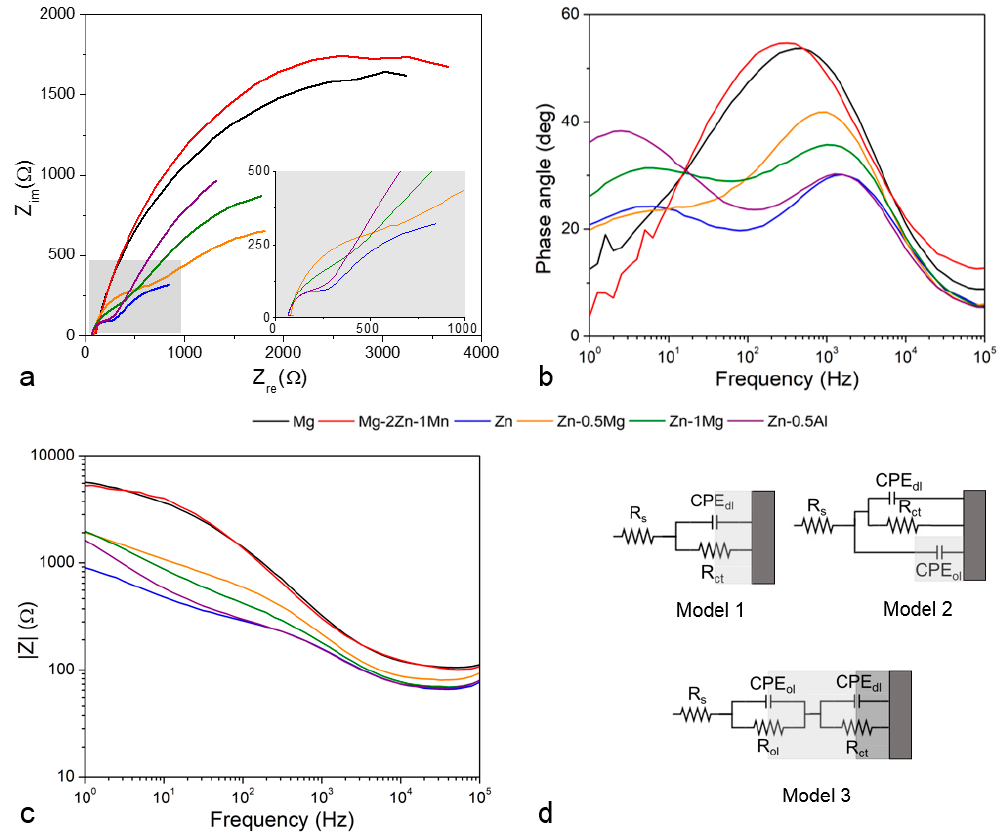
Figure 5. Typical electrochemical impedance spectroscopy (EIS) results: ( a ) Nyquist plots, ( b ) Bode phase angle plots, ( c ) Bode impedance plots, and ( d ) proposed equivalent electrical circuit models. Note that at very low frequency the Mg specimens show some negligible scatter.